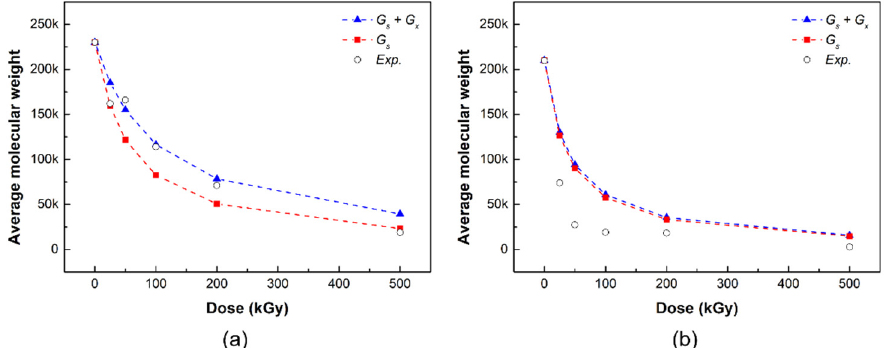
Figure 6. Comparison of number average molecular weight of ( a ) PLCL and ( b ) PLDLA in simulation and measurement evaluation (blue triangles: simulation of chain scission and crosslinking, red squares: simulation of chain scission, white circles: experimental value).